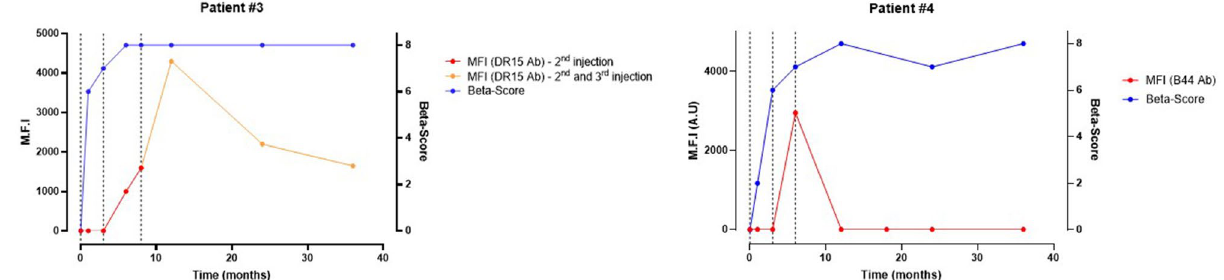
Figure 4. Evolution of β-Score over time in type 1 diabetic pancreatic islet recipients presenting with high or low early de novo Donor Specific Antibodies. Patient#3 (left panel) presented at 3 months post-injection with high-MFI de novo DSA targeting the 2nd islet infusion which became the preformed DSA of the 3rd infusion. Patient#4 (right panel) presented with a low-MFI early and transient DSA targeting the 3rd islet infusion, also at 3 months post-injection. Vertical dash lines represent every pancreatic islet injection. Ab Antibody; MFI Mean- Fluorescence